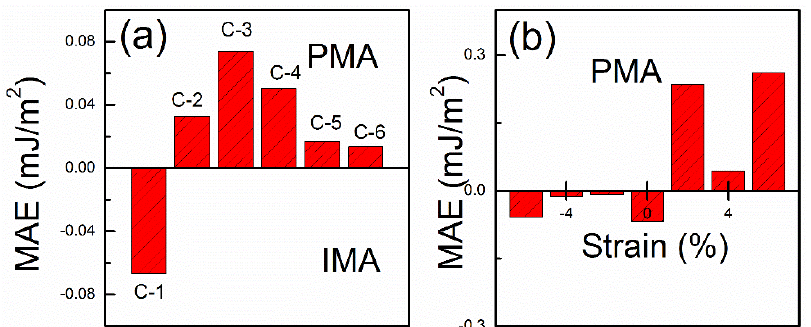
Figure 6. The total magnetic anisotropic energy (MAE) of di ff erent configurations ( a ) and C-1 with di ff erent strains ( b ). The positive value favors perpendicular magnetic anisotropy (PMA) and negative favor in-plane magnetic anisotropy (IMA). In ( b ), the negative strains stand for the compressive strain, while the positive values represent the tensile strains.